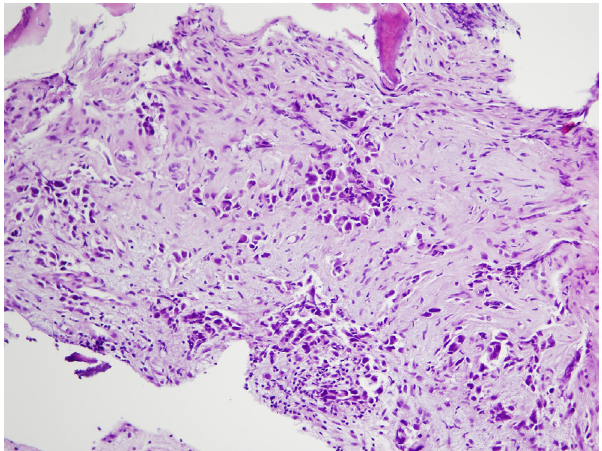
Figure 2 Immunohistochemical analysis: atypical tumor cells that show strong and diffuse nuclear positivity for TTF-1 anti- body. Streptavidin-biotin, original magnification 400 × . Temporal bone computed tomography (CT) revealed mucosal thickening within the mastoid air cells, osteolytic lesion in the left mastoid and occipital bone and the het- erogeneous mass in the middle ear structures (Fig. 1). Treatment with intravenous antibiotics ensued (Ceftria- xone 2 g/per day), without any improvement of symptoms. Patient had no signs or symptoms of the malignant disease; chest radiography showed no signs of lung